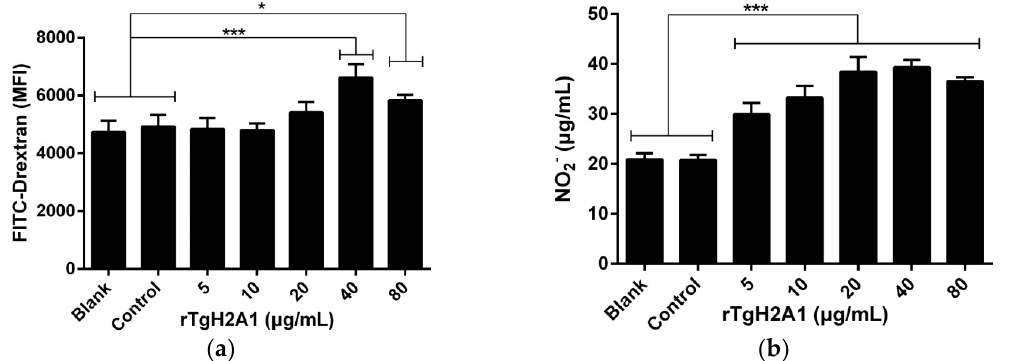
Figure 5. rTgH2A1 induced phagocytosis and NO secretion of the murine macrophages in vitro. Preincubated with different concentrations (0, 5, 10, 20, 40, and 80 μg/mL) of rTgH2A1 for 48 h, phagocytosis and NO secretion were respectively determined by flow cytometry and commercial kits.